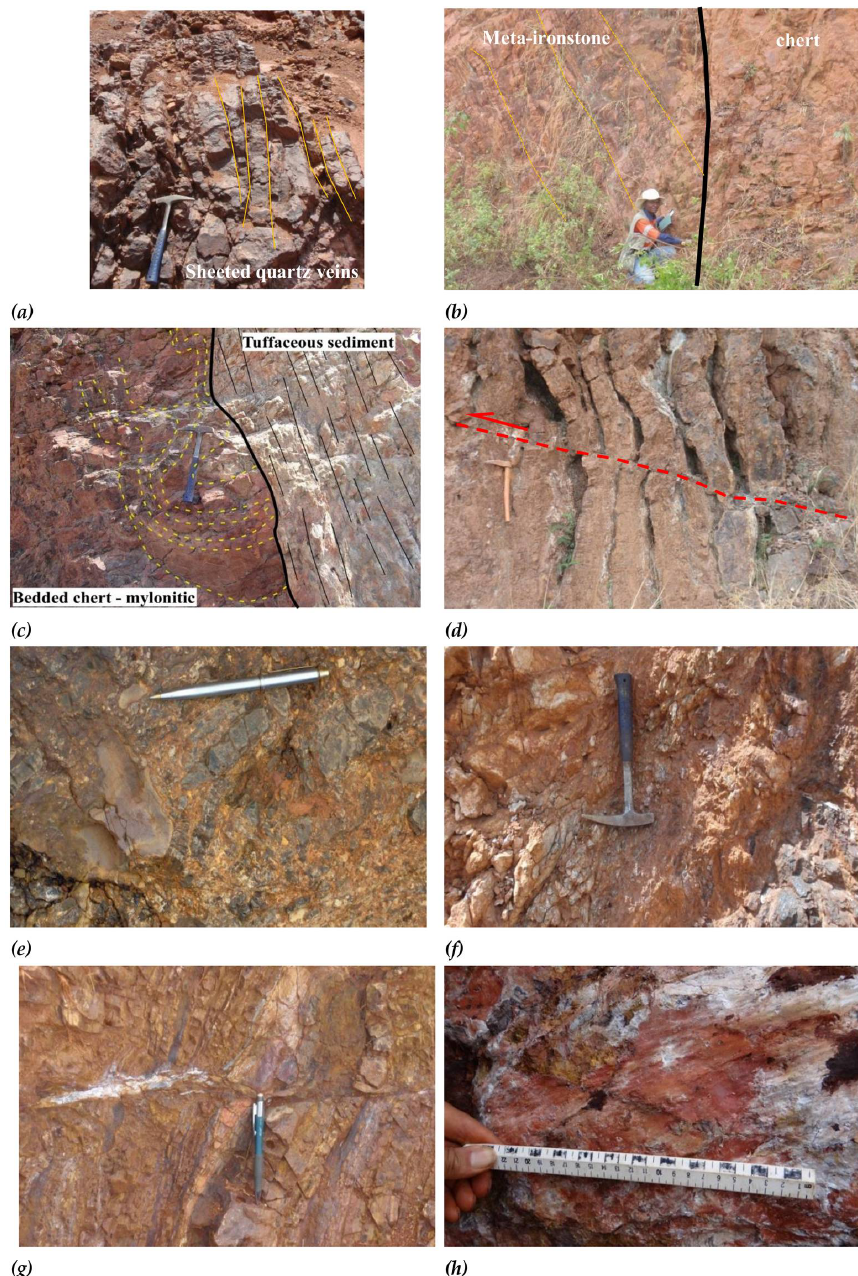
Figure 5. Examples of shear zones in the Kukuluma terrain: ( a ) Closely spaced magnetite-bearing sheeted quartz veins intruded along a D 1 shear zone (Kukuluma pit); ( b ) Planar chert ridge (right) cuts at a low-angle through primary bedding in a meta-ironstone unit along access road to Kukuluma. The chert is interpreted as a D 1 shear zone; ( c ) Planar chert horizon east of Area 3. The margin of the chert parallels S 0 in the surrounding sediments, but internally the chert is folded with mylonitic characteristics attributed to D 1 ; ( d ) D 5 low-angle reverse fault and associated recumbent folding in chert in Kukuluma pit; ( e ) Cataclasite and tectonic breccia zone along the D 6 shear zone in chert in Kukuluma pit; ( f ) D 6 , Kasata shear in the northwest corner of the Matandani pit; ( g ) D 7 fracture plane characterized by the presence of (white) sericite and sulphide alteration in artisanal workings along the western wall of Matandani pit; ( h ) D 7 fracture plane with (white) sericite and slickenlines indicative of normal-sinistral movement in artisanal workings along the western wall of the Matandani